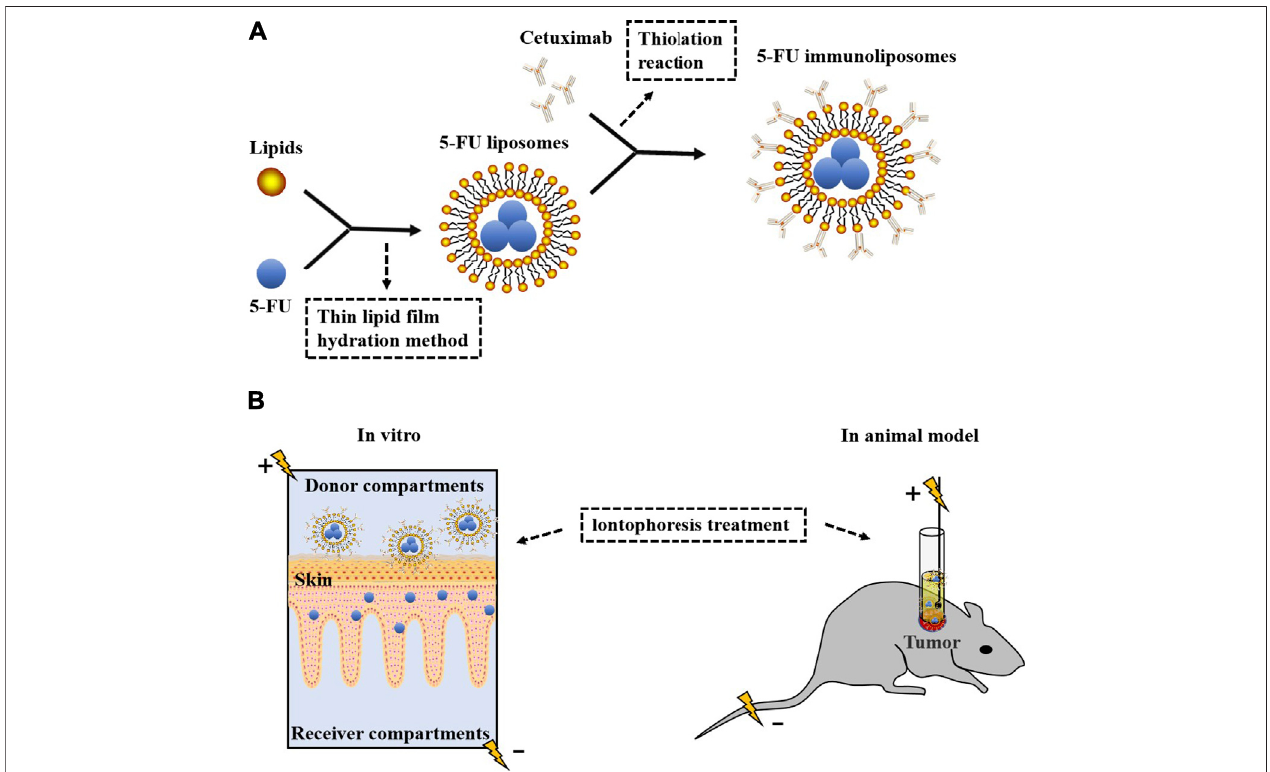
FIGURE8| PreparationofILsandiontophoresistreatment invitro and invivo . (A) 5-FUliposomeswerepreparedbycoating5-FUwithlipidsaccordingtothedrug- to-lipid ratio of 0.1 by the thin lipid fi lm hydration method and then connected with thiolated cetuximab to form 5-FU ILs. (B) In vitro , iontophoresis with ILs increased the penetrationrateof5-FUintotheskinandaccumulatedinthelivingepidermisbutdidnotenterthereceivercomponents.Immunoliposomeiondeliveryismoreeffectivein treating tumors in animal models.